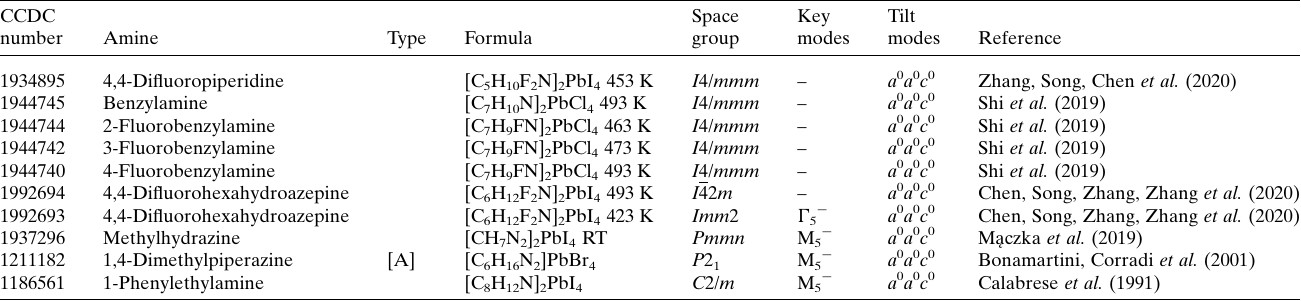
Table 1 Summary of experimentally known RP-derived structures with a RP (cid:3) a RP (cid:3) c RP unit-cell metrics. The parent structure type is the RP phase ( I 4/ mmm ). The ‘Type’ column in all Tables is merely intended to highlight the structures with divalent [A] or mixed- cation [A][A 0 ]